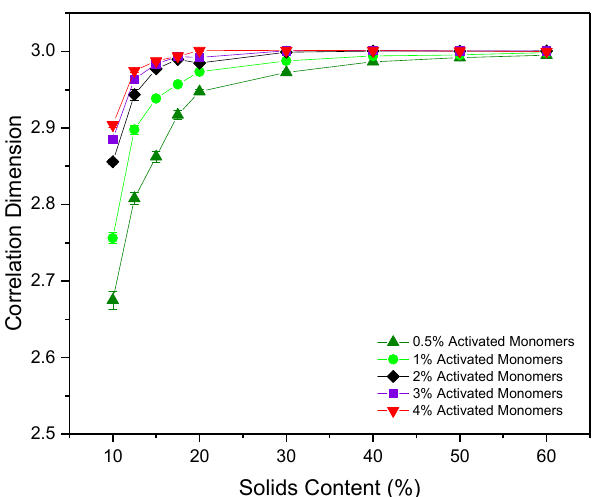
Figure 6. Correlation dimension values calculated for simulated materials at varying solids content ( S c ) and activated monomer ( C c ) values. Standard deviation error bars are present around each data point, although may not be visible due to their size relative to the data point marker.